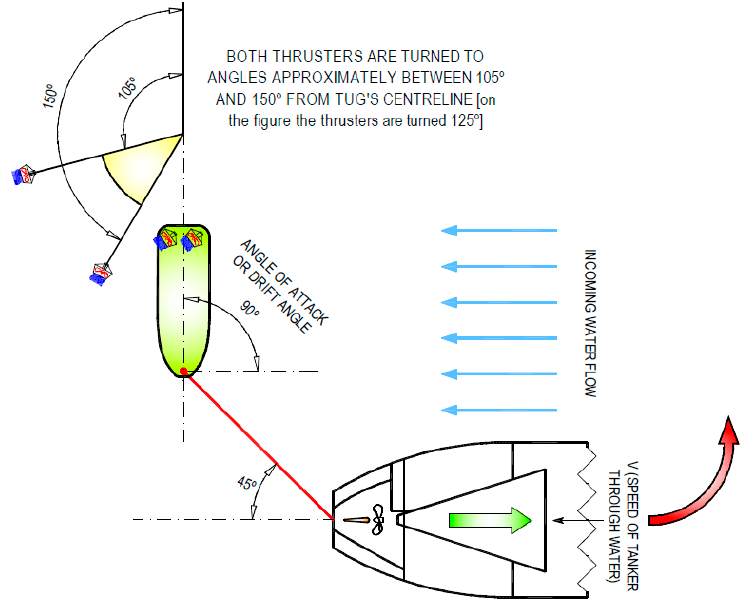
Figure 7. Combination mode towing method by an ASD (7–10 knots). Drawing: Authors.